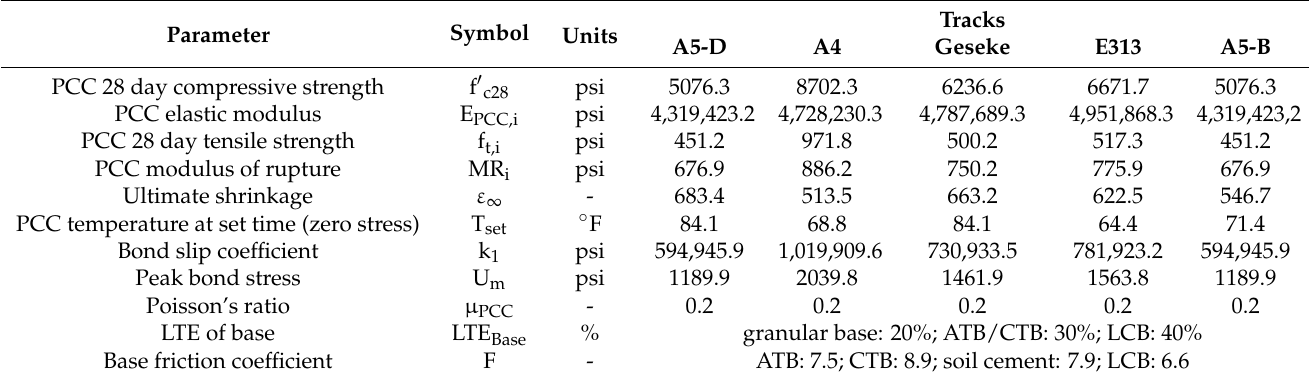
Table 3. PCC mixture input parameter.